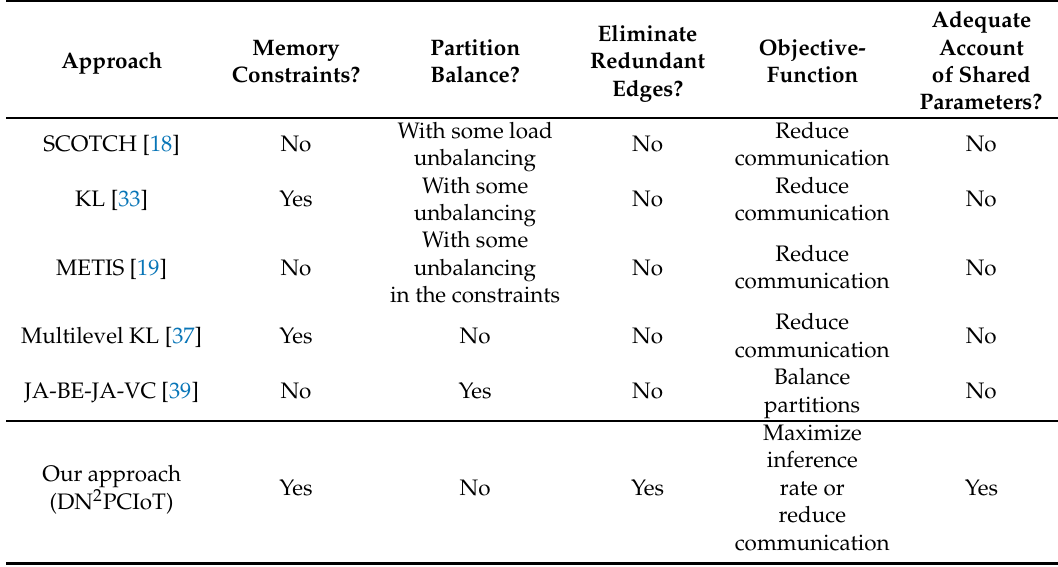
Table 2. Summary of partitioning algorithms discussed in the related